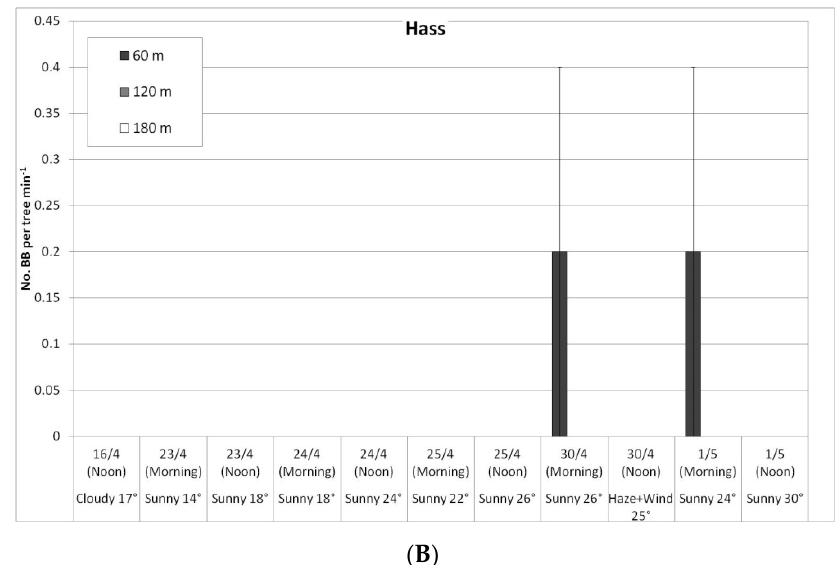
Figure 5. Daily number of bumblebees (BBs) on ‘Ettinger’ ( A ) and ‘Hass’ ( B ) trees at three distances from the BB hives (60, 120, and 180 m), Kfar Giladi, April 2019. Data are means of five trees at each distance ± SE.